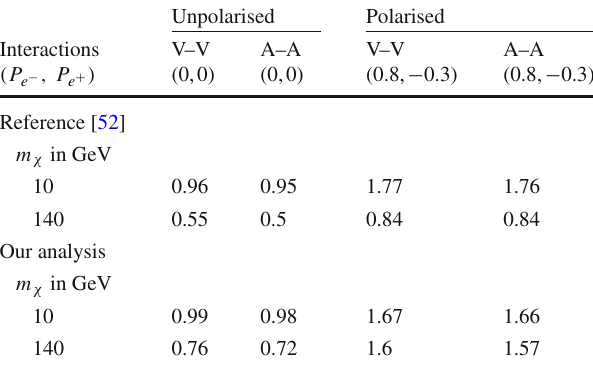
is taken to be MN